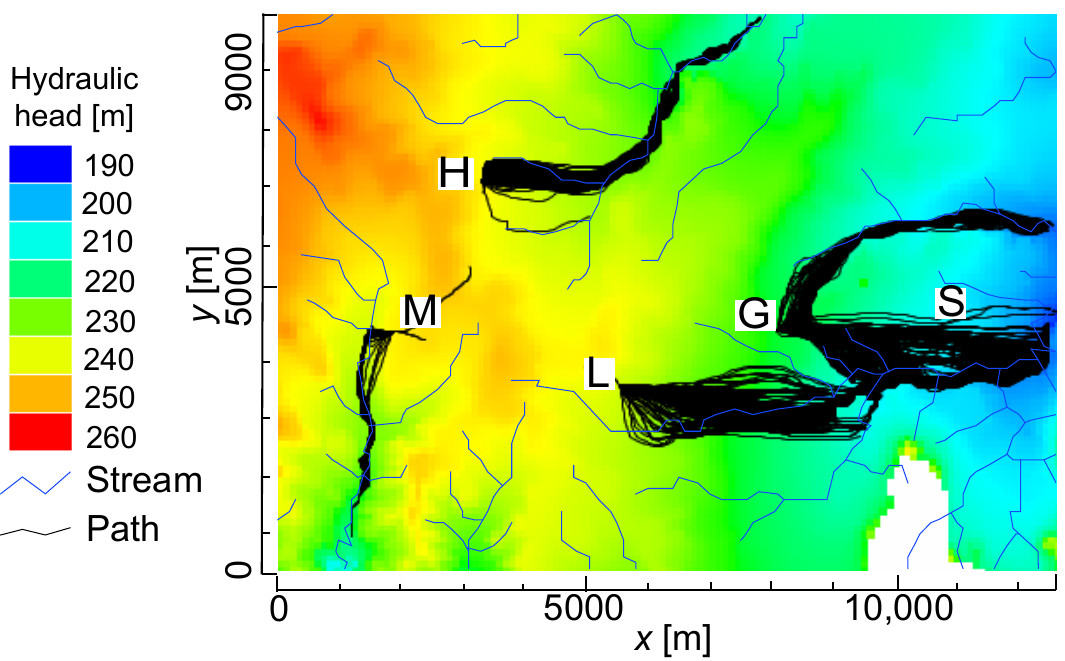
Figure 13. Particle paths for 882 realizations with background colored according to a representative hydraulic-head distribution (the white region in the southeast is an inactive portion in the model domain). Dark red semicircles represent suggested barriers to prevent contaminant spreading. Table 1. Median travel times for the 882 pre-calibration and NSMC parameter fields used for particle tracking. Upward arrows indicate an increase and vice versa for the downward arrows. Particle